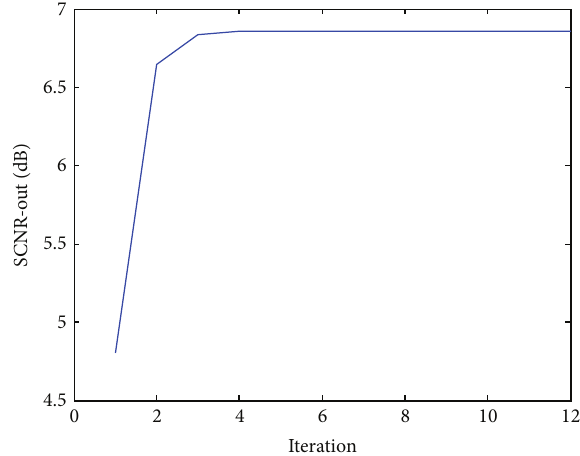
Figure 4: The output SCNR versus the number of